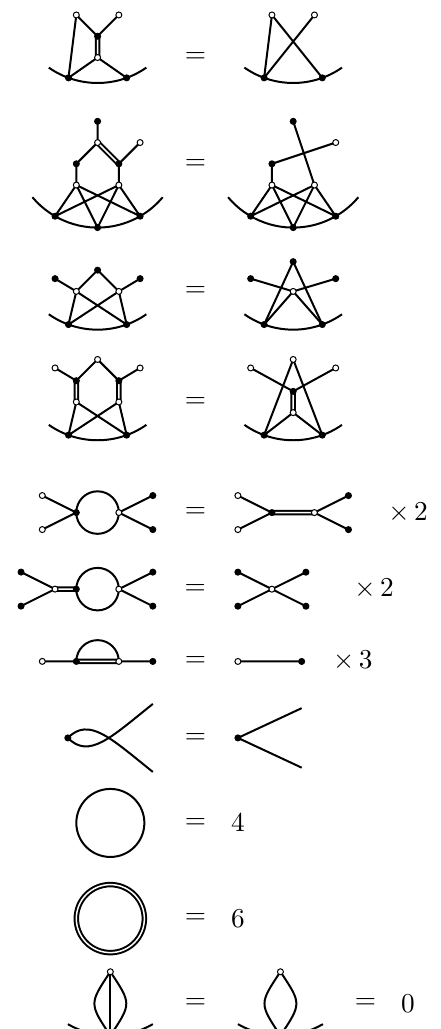
δ e = δ d δ e + (cid:15) abc (cid:15) ade c c b b